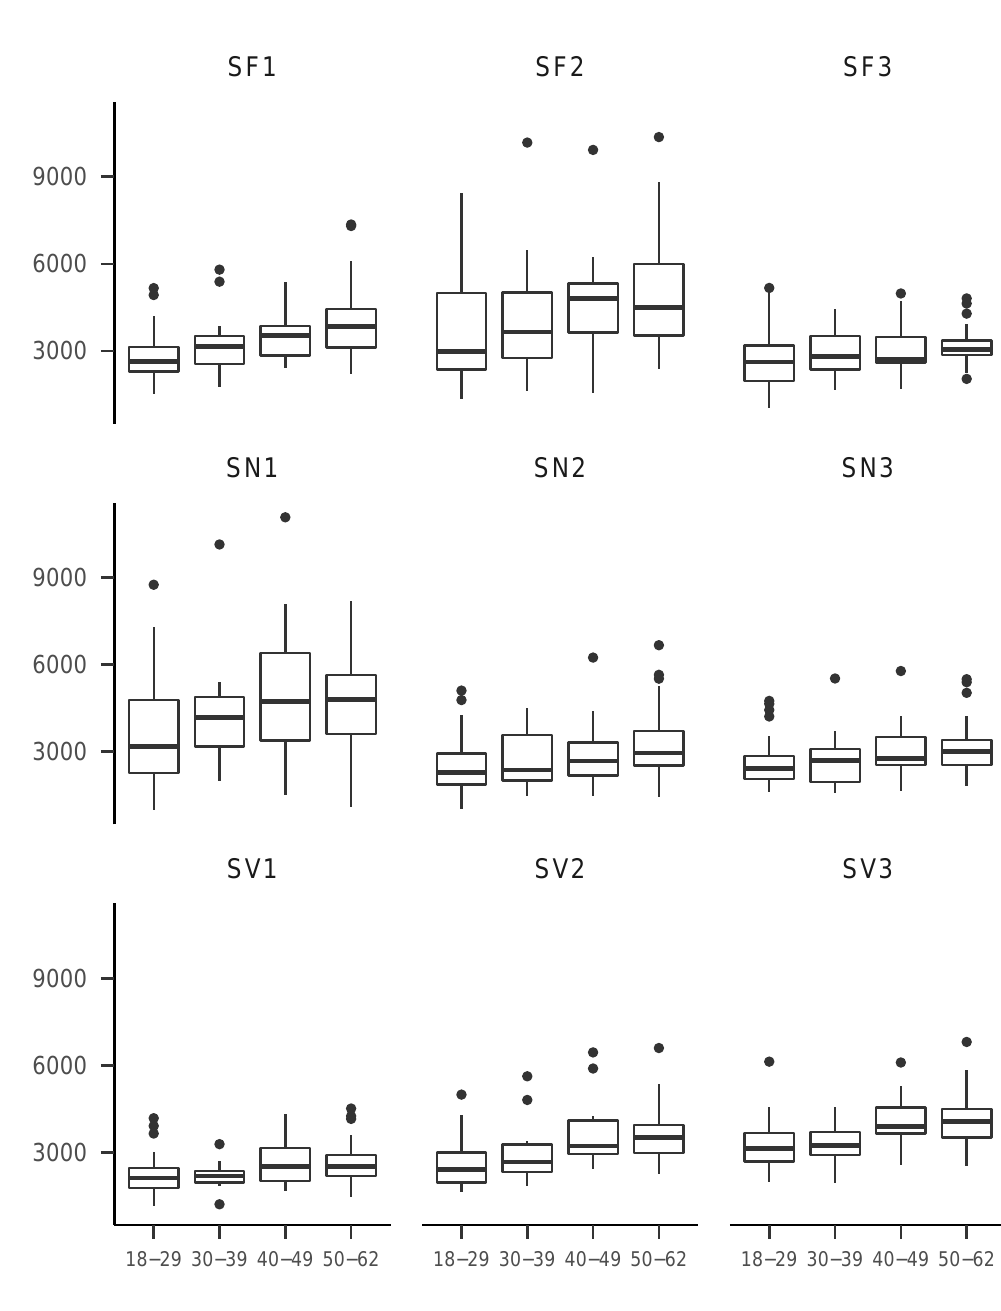
Figure A2. Boxplots of mean response times for all slow tasks, split by age groups. See Table 1 for an explanation of the task